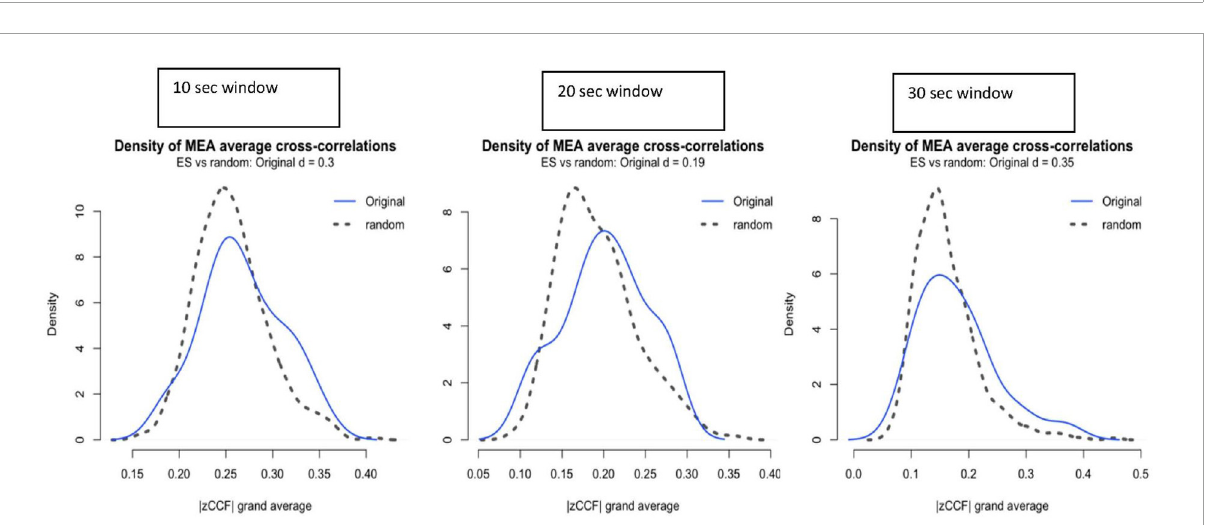
FIGURE3 Effect size (ES) of synchrony above pseudosynchrony for window sizes of 10, 20, and 30 s. |zCCF|, Fisher’s Z absolute mean cross-correlation.